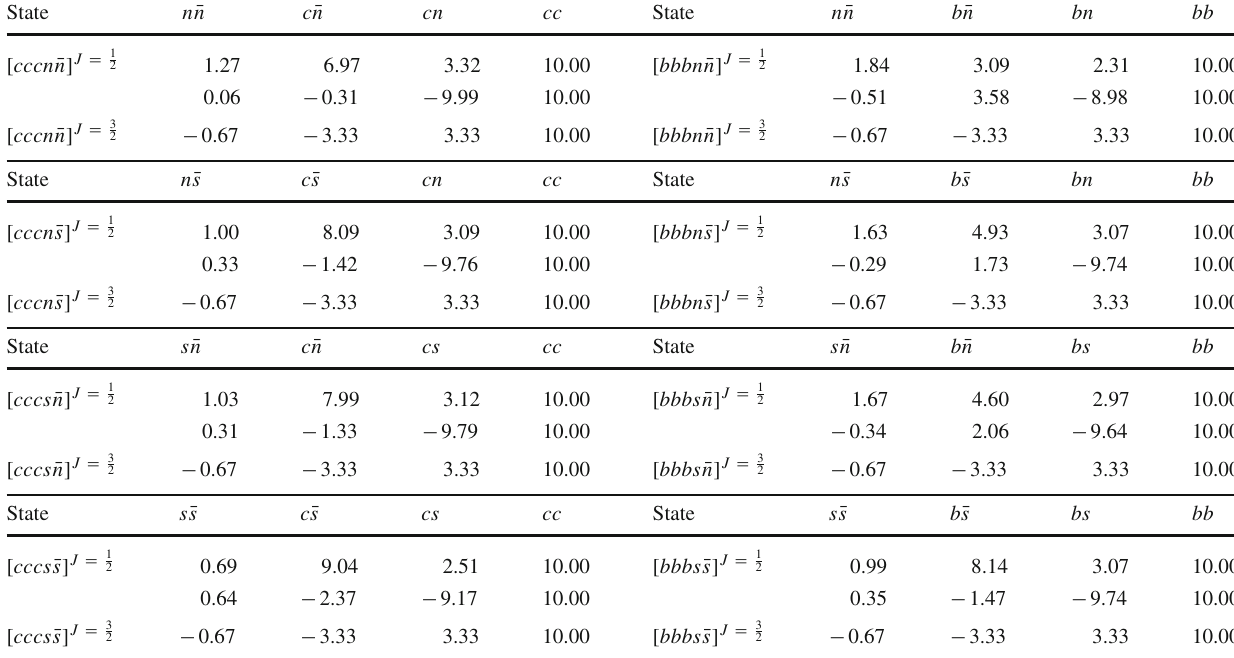
Table 9 Values of K ij when reducing the coupling strength C ij between the i th and j th quark components by 0.01%. The orders of states are the same as those in Tables 5 and 6